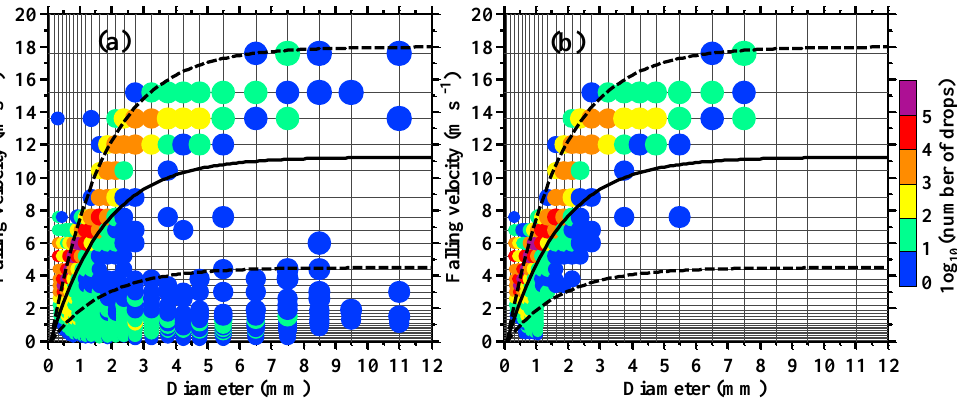
Figure 2. Raindrop numbers in the different diameter and falling-velocity classes before ( a ) and after ( b ) quality control (QC) for the entire dataset. The solid line represents the theoretical diameter/falling velocity relationship, as shown in Equations (1) and (2). The dashed line indicates the ±60% range of the relationship.